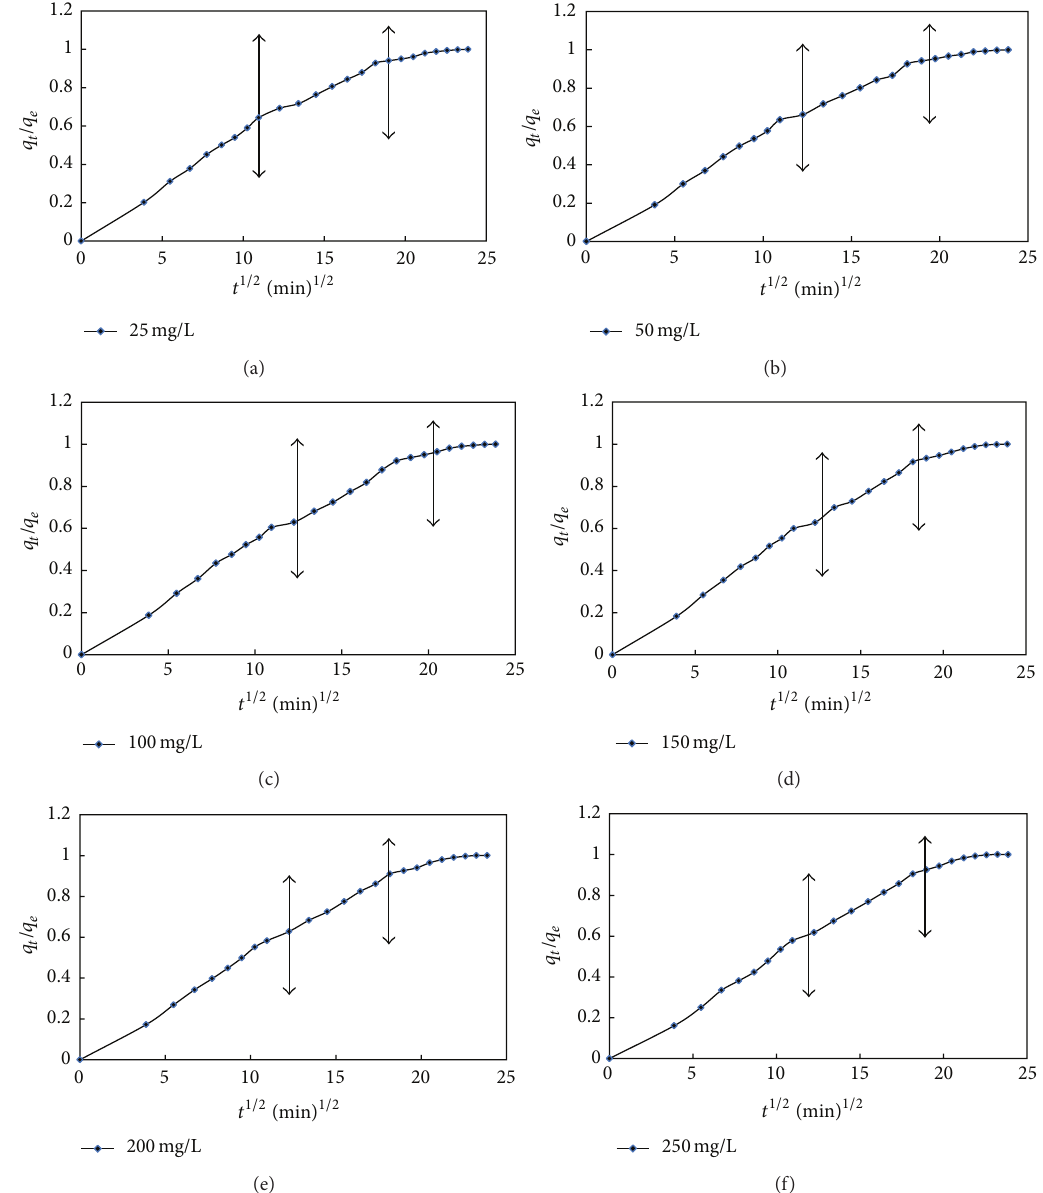
Figure 2: The plot of 𝑞 𝑡 /𝑞 𝑒 versus 𝑡 1/2 showing all three regions for adsorbent treated with KOH for the adsorption of phenol.